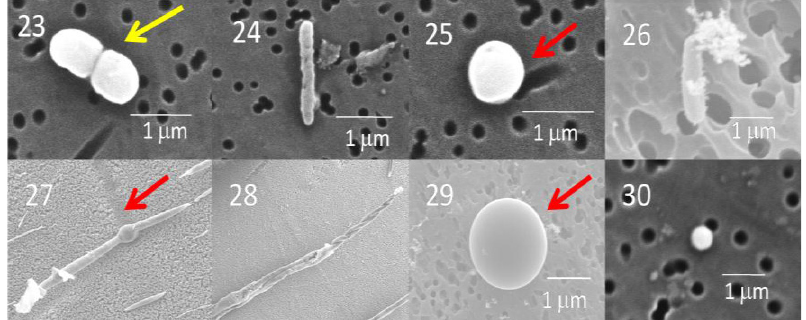
Figure 3. Scanning electron micrographs of bacteria from the Vostok 5G ice core section (micrographs 23 (cid:177) 25, 316 m; 26 (cid:177) 27, 900 m; 28 (cid:177) 30, 1,529 m). No organisms were observed in the Vostok 5G 2,149 m ice core. Also, no cultures were obtained from this core section (Table 1). Diplococcoid organisms similar to the ones observed in the GISP2D cores were evident in micrograph 23 (yellow arrow). The microbe in micrograph 24 has a spiral structure and may be related to Spirochaetales. Spore-like structures were observed commonly (red arrow). A fungal hyphae-like structure was observed in the Vostok 5G 900 m ice core (panel 27). The spherical form in micrograph 29 appears to be a fungal coniduim. The microbes in Panels 25 and 30 are very small, similar to ultramicrobacteria found previously in the GISP2D ice core [28,29].